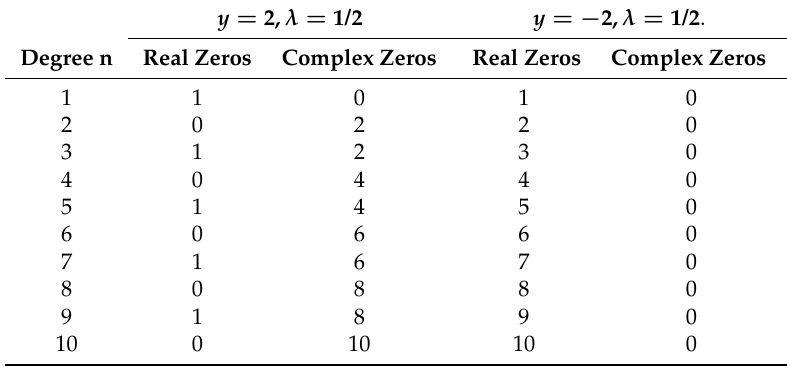
Table 1. Numbers of real and complex zeros of H n ( x , y , λ ) =